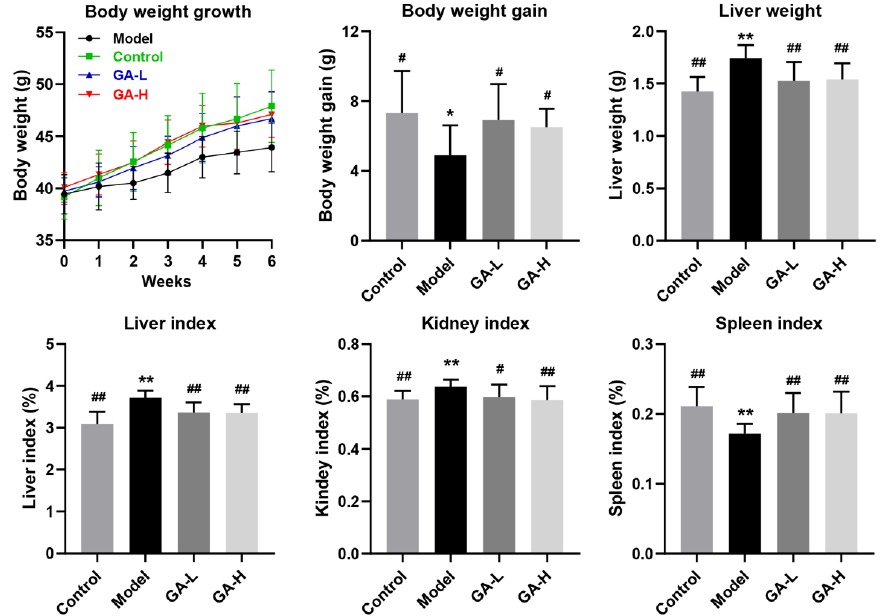
Figure 1. Effects of GA intervention on the body weight, liver weight, organ index (liver, kidney and spleen index) in mice with excessive alcohol intake. Values were expressed as mean ± SD, and ## p < 0.01 and # p < 0.05, versus the model group; ** p < 0.01 and * p < 0.05, versus the control group.